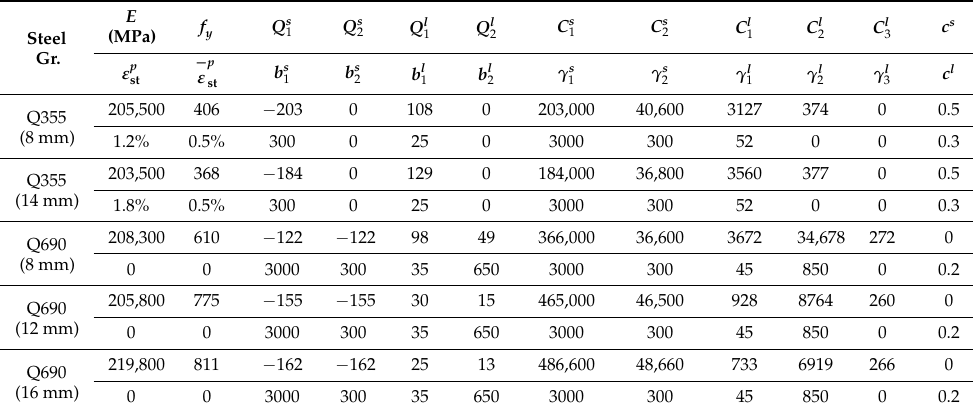
Table 1. Calibrated parameters of steel